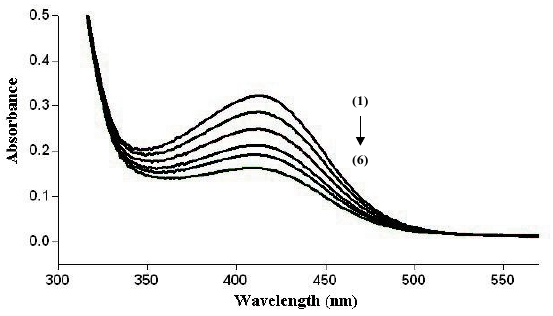
Figure 1. Spectroscopic changes occurring in the oxidation of L-tyrosine by DPC at 298.1 [DPC] = 5.0×10 -5